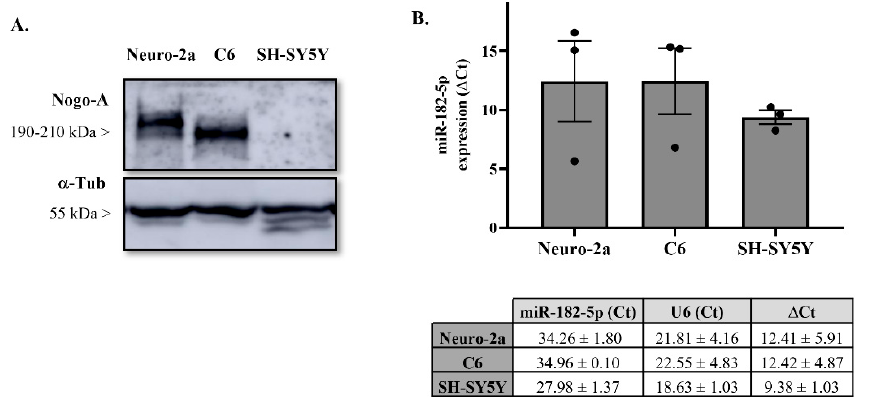
Figure 2. Endogenous expression levels of miR-182-5p and Nogo-A protein in different cell lines. ( A ) Representative immunoblot of Nogo-A and load-control α -tubulin protein expression in differ- ent cell line lysates of three independent experiments. ( B ) RT-qPCR showing relative miR-182-5p expression in total RNA samples isolated from different cell lines. Expression of miR-182-5p from each sample was normalized to the corresponding expression of the control gene snoRNA U6 ( ∆ Ct = CtmiR 182 − Ct U6 ). The bar graph and table represent the mean ± SEM data of Ct and ∆ Ct from three independent experiments.